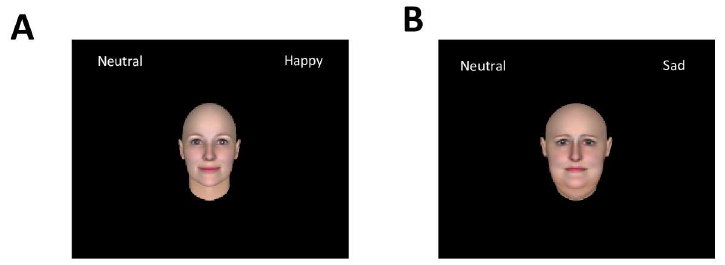
Fig 2. Affective perceptual judgment task. A. Sample screen of the neutral-happy judgment task (Experiment 1). B. Sample screen of the neutral-sad judgment task (Experiment 2). Participants were asked to make perceptual judgmentsabout the emotionof faces (neutral vs. happy; neutral vs. sad) in a two- alternative forced-choice procedure.The spatiallocationsof emotioncategory labels were counterbalanced across